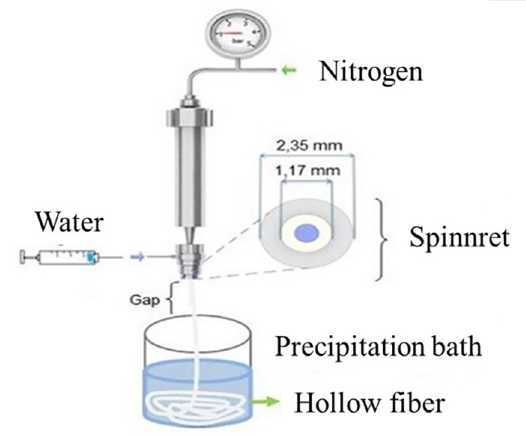
Figure 1. Schematic representation of the extruder and the hollow fiber membranes process 18 . The parameters for hollow fiber membranes preparation are defined in Table 1 and were obtained through preliminary tests, analyzing the viscosity of the solution, the GAP, the flow of the internal liquid and as well as the flow of the polymeric solution.